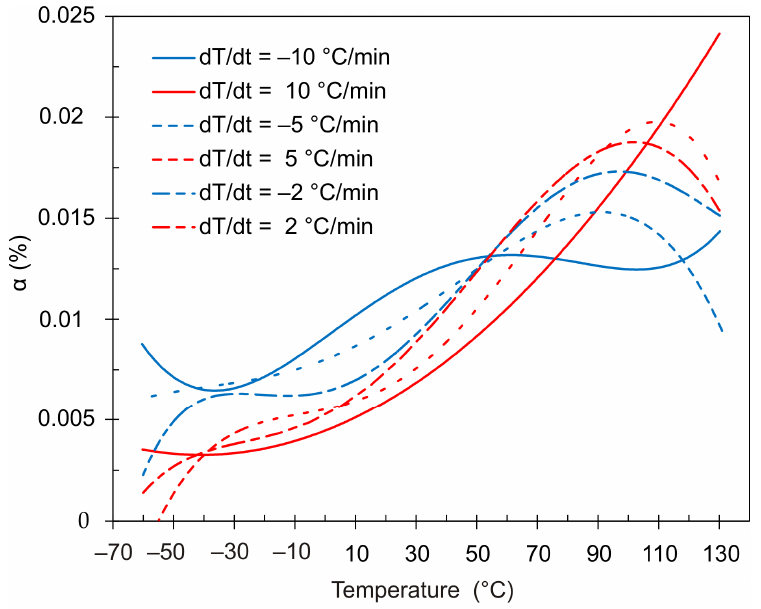
Figure 13. Dependence of the thermal expansion coefficient α (T) for a 42 μ m thick film sample made of DeSolite DS-2015 polymer, with different cooling/heating rates: 10 °C/min (heating—solid red line/cooling—solid blue line); 5 °C/min (red/blue dash line); 2 °C/min (red/blue dash-dot line).